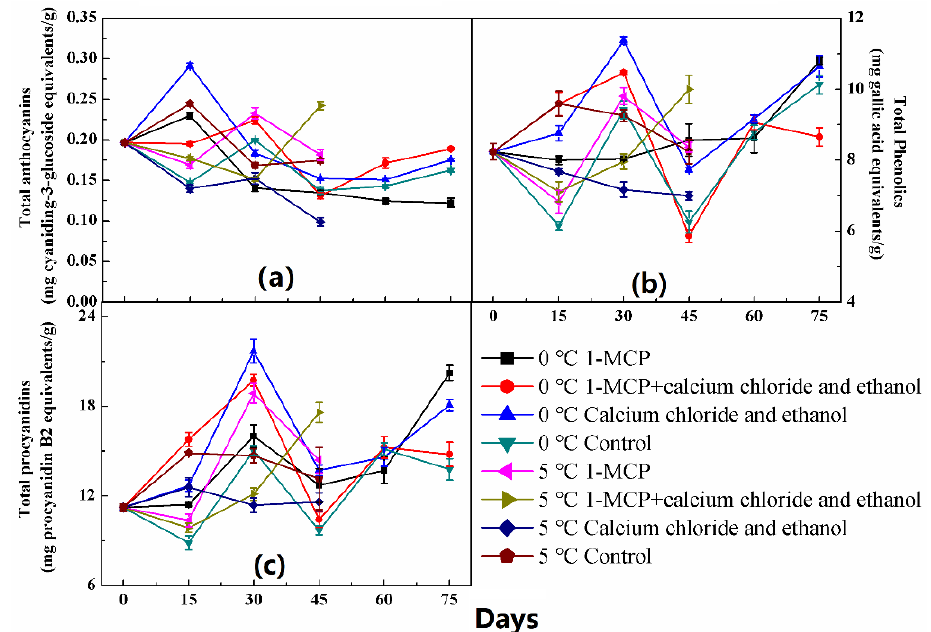
Figure 3. Dynamic changes of total anthocyanins ( a ), total phenolics ( b ), and total procyanidins ( c ) value of grape skin. The data is presented as mean ± standard error (SE) of at least three repetitions.